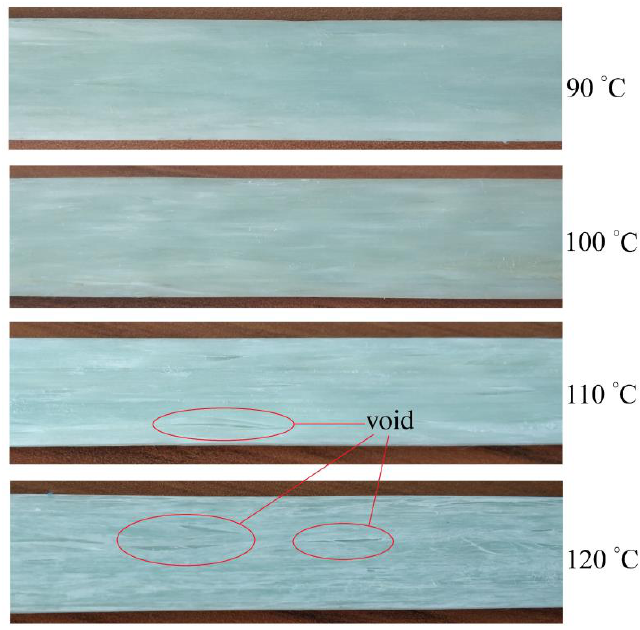
Figure 6. Surfaces of pultruded composites with 70 wt% glass fibers at various temperatures of the injection chamber.